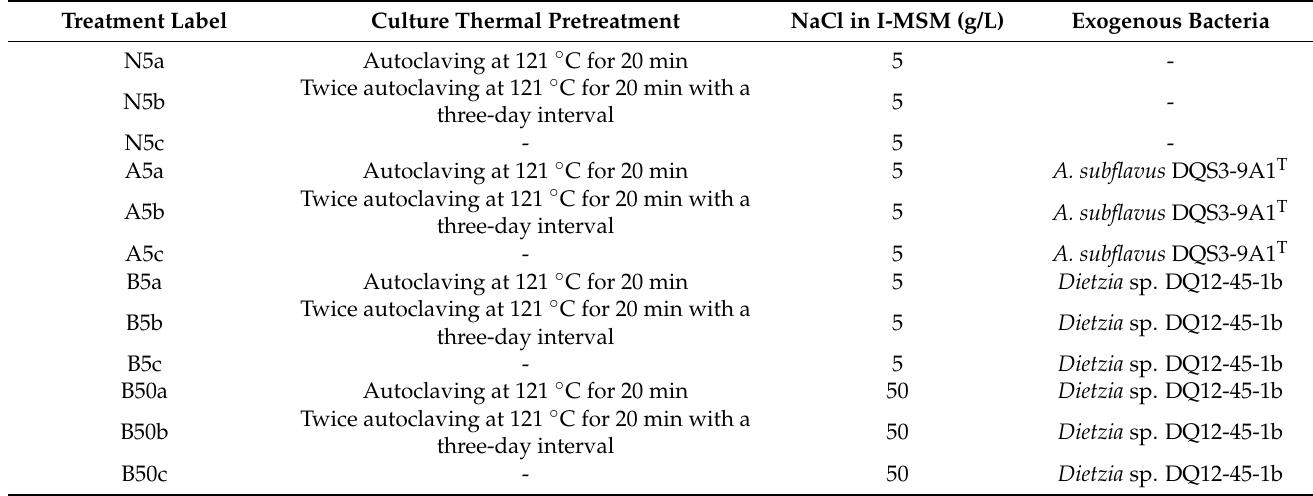
Table 1. Summary of the experimental